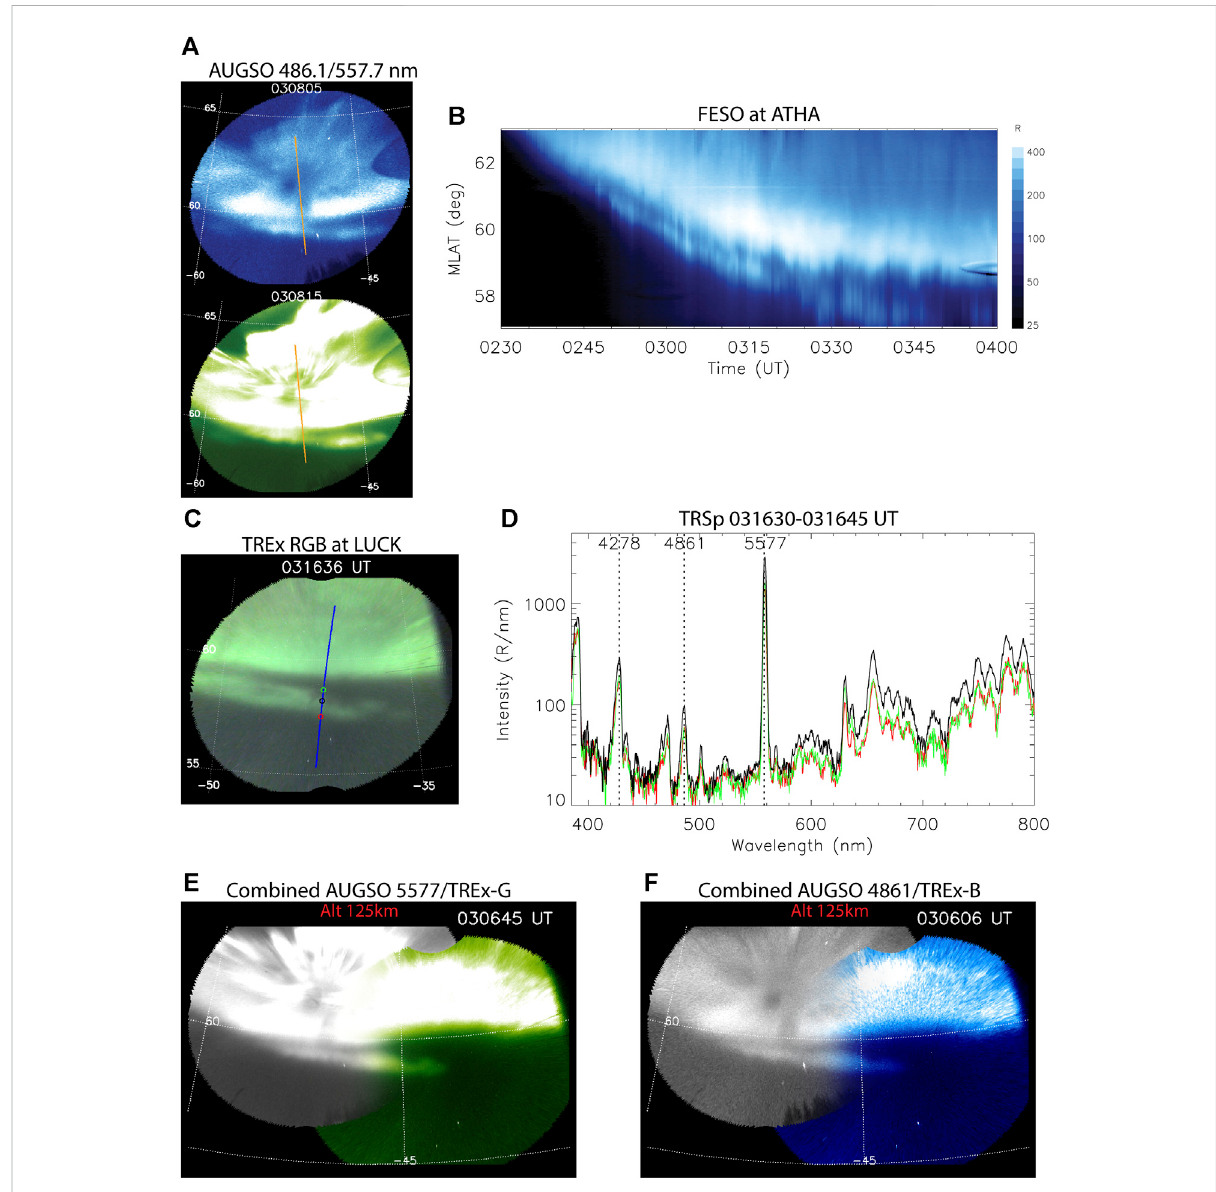
FIGURE 2 (A) ExampleofATHAAUGSO486.1and557.7 nmimages,withFESOscanlineoverplotted. (B) 486.1 nmprotonauroralintensityversustimeand MLATobservedbyFESO. (C) ExampleofTREXRGBASIimage,withTRSpscanlineoverplotted.ThreecoloredcirclesalongtheTRSpscanlinedenote wheretheTRSpdataaresampledtobeshownin (D) .In (A – C) ,anemissionaltitudeof125 kmisassumed. (D) ExampleoftheTRSp-measuredoptical spectraforthreebinslabeledin (C) .TheblackcurvecorrespondstothespectrumofIPA,whilethegreen/redcurvesdenotethespectrumofthe northern/southern edge outside the IPA. (E) An example of the combined image maps of AUGSO 557.7 nm and TREX RGB ASI green-channel based on the best- fi t altitudes of IPA from triangulation analysis. The overlapping FoV of the two ASIs is presented as an alpha-blending overlay of two images. (F) Similar to (E) but an combined image maps of AUGSO 486.1 nm and TREX RGB ASI